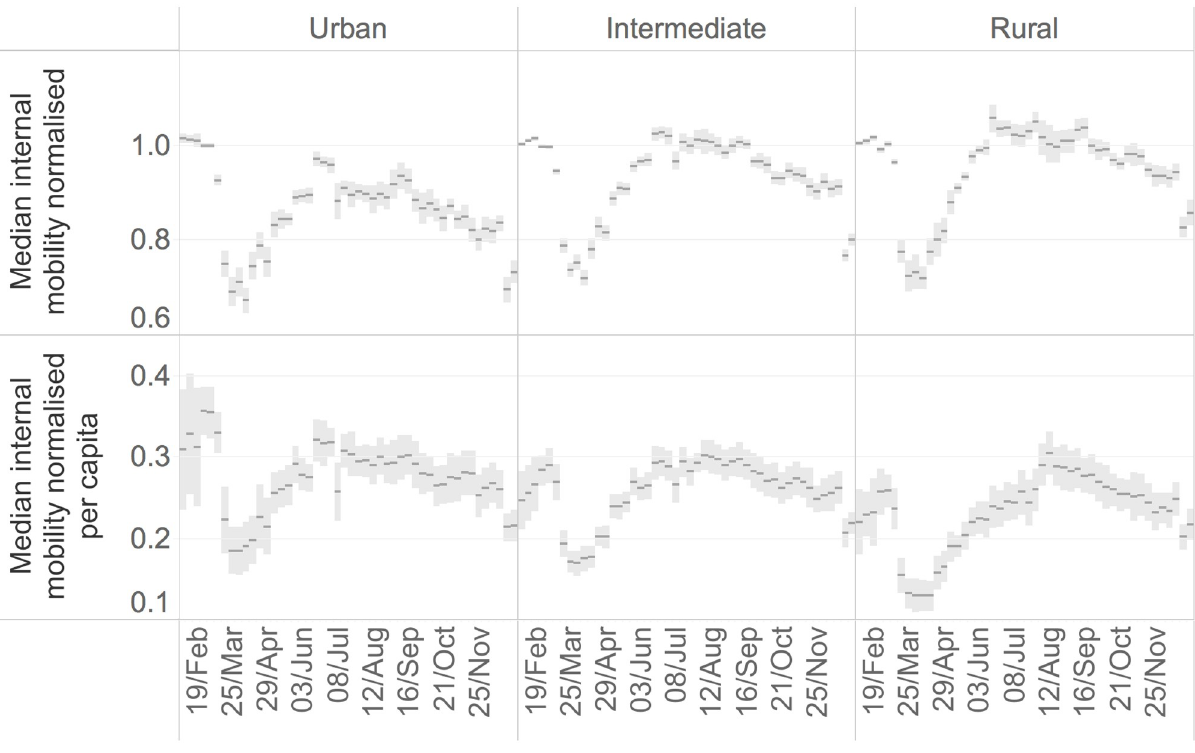
Fig 4. Median normalised internal mobility and internal mobility per capita with 95% CI, across regions grouped by rural-urban typology.